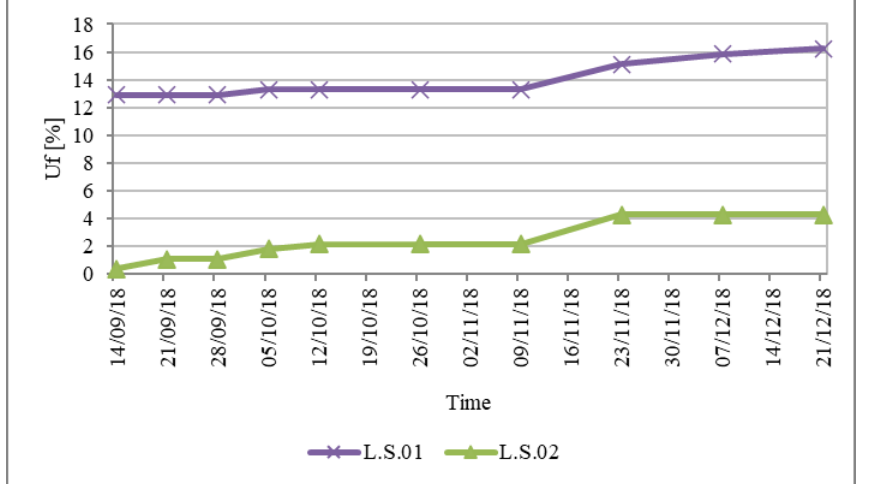
Figure 8. Moisture-time absorption curves for Lecce stone blocks (L.S.).